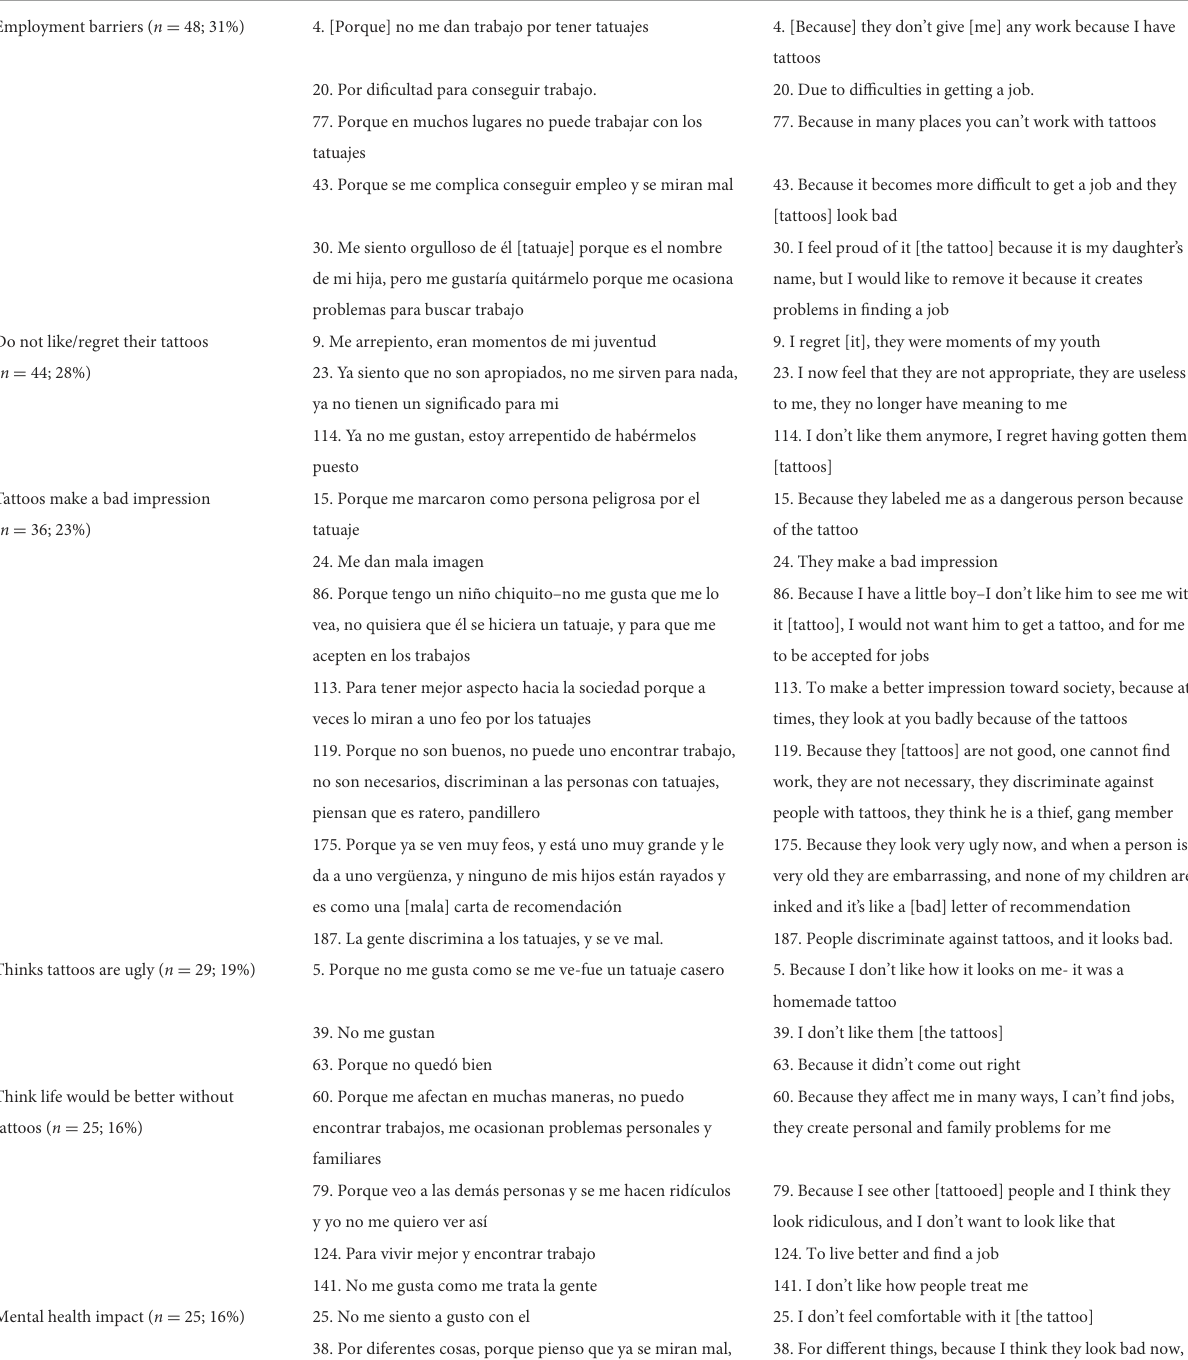
TABLE 3 Reasons for interest in receiving tattoo removal expressed by Mexican tattooed adults ( n = 156) receiving free medical care, Tijuana, Mexico, 2013. Spanish Language